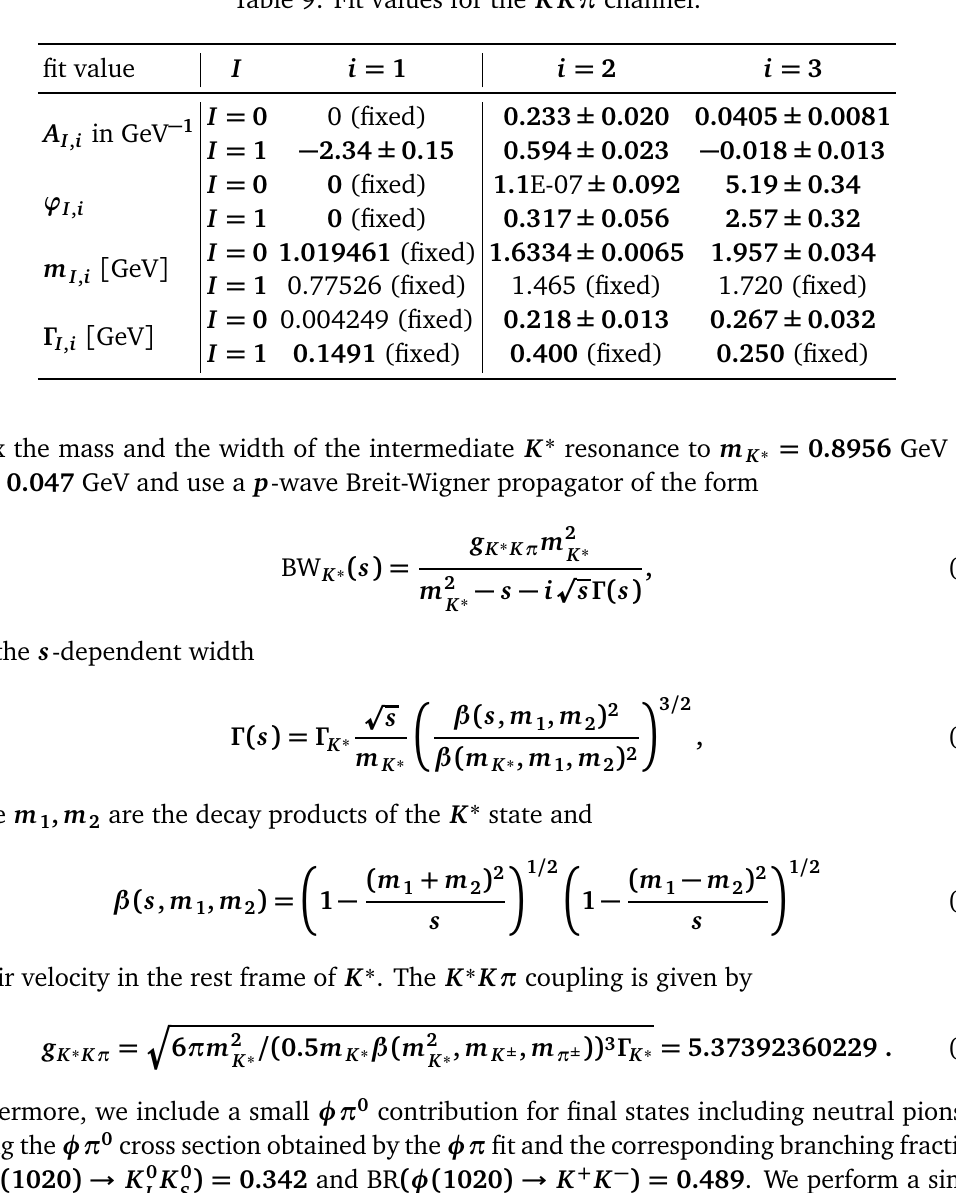
Table 9: Fit values for the K K π